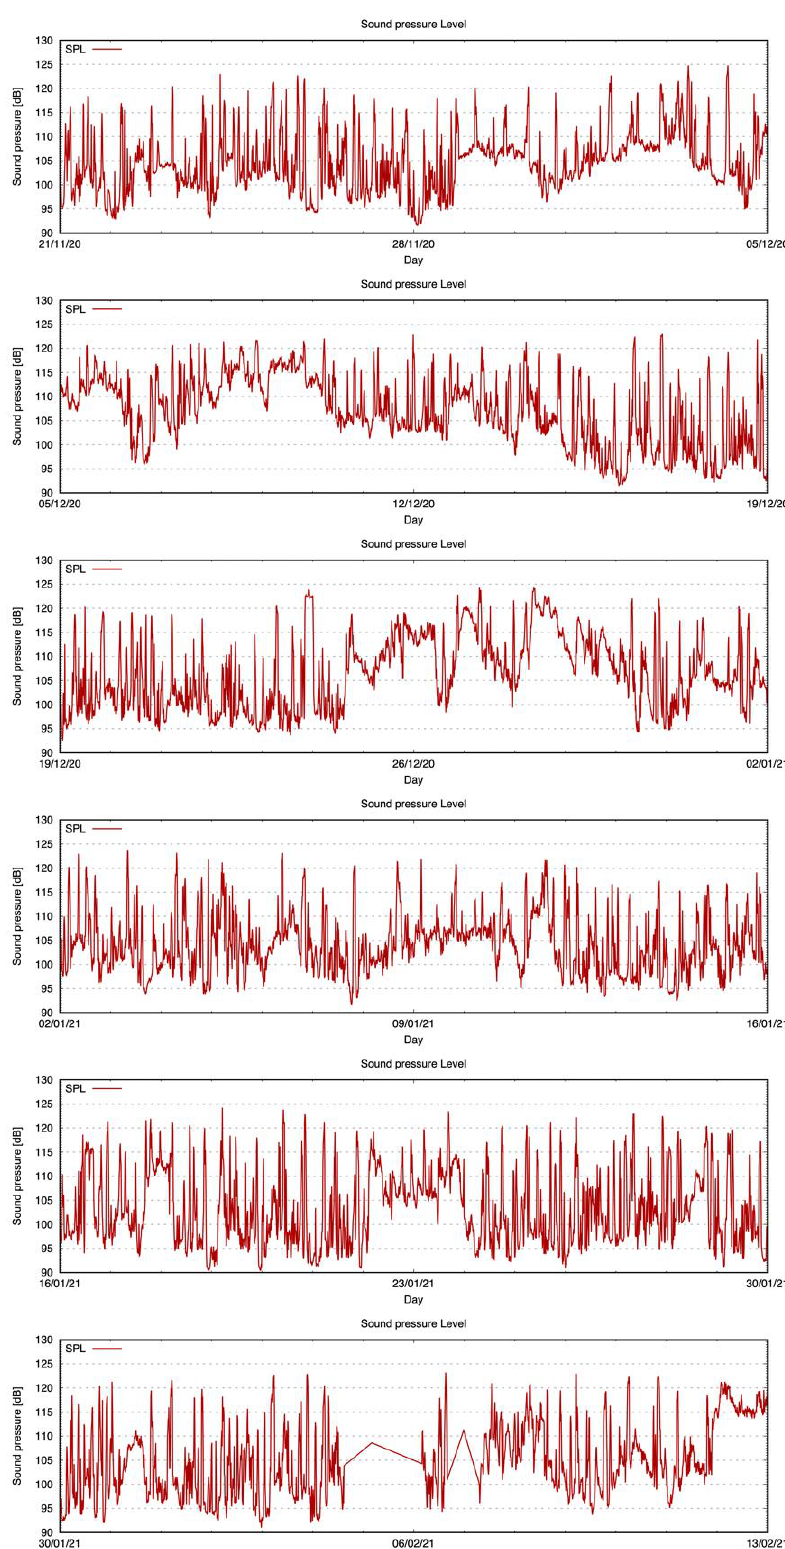
Figure 10. SPL time series between 21 November 2020 and 13 February 2021, each graph shows recordings during two weeks. recordings during two